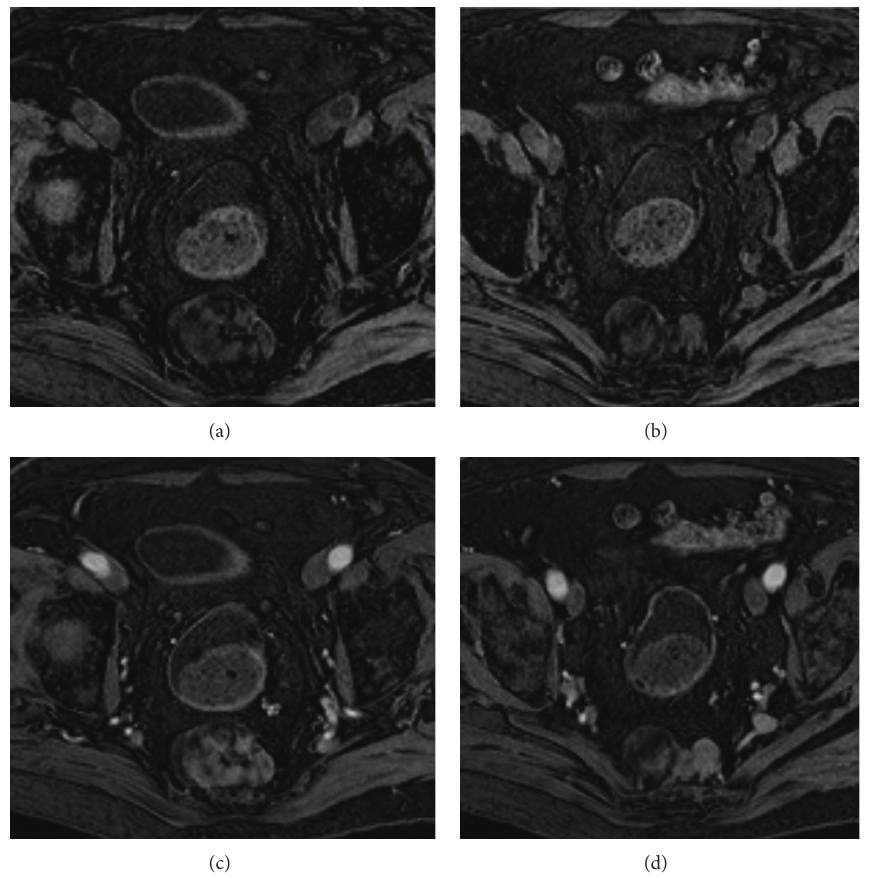
Figure 3: 84-year-old male with presacral myelolipoma. Postcontrast T1-weighted fat-suppressed axial images at a higher (a) and lower (b) level of the mass demonstrated avid gadolinium uptake of the solid hematopoietic components of the lesion.